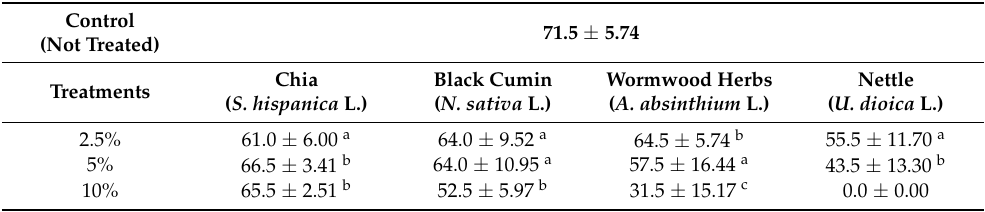
Table 5. Comparison of differences of means for pepper seeds germination ( C. annuum L.) (The values in the table represent the mean value of germination rate in % ±